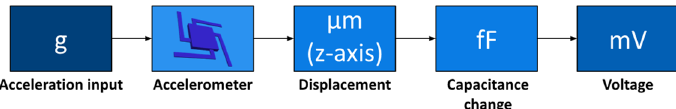
Figure 5. The system-level model of the MEMS accelerometer.